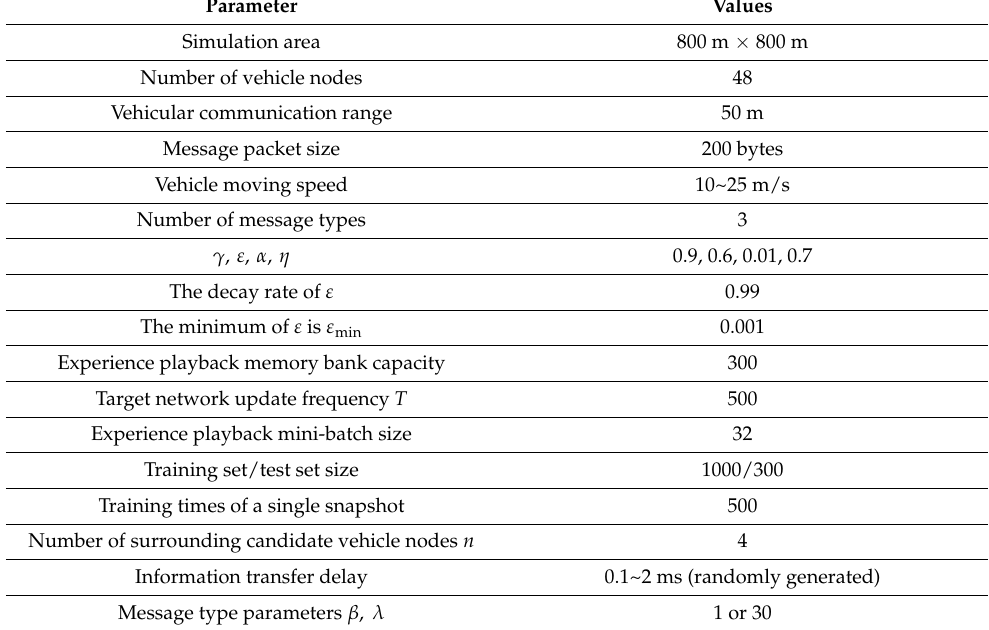
Table 2. Simulation parameter